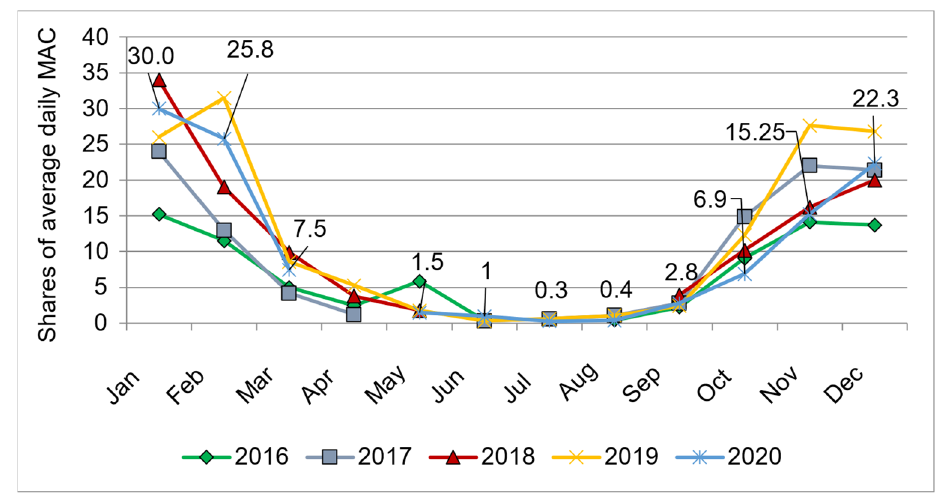
Figure 1. Annual dynamics of benzo( a )pyrene concentrations in the air of Ulan-Ude in 2016–2020, measured at the air monitoring stations (operated by the Buryat CHEM), shares of MAC.